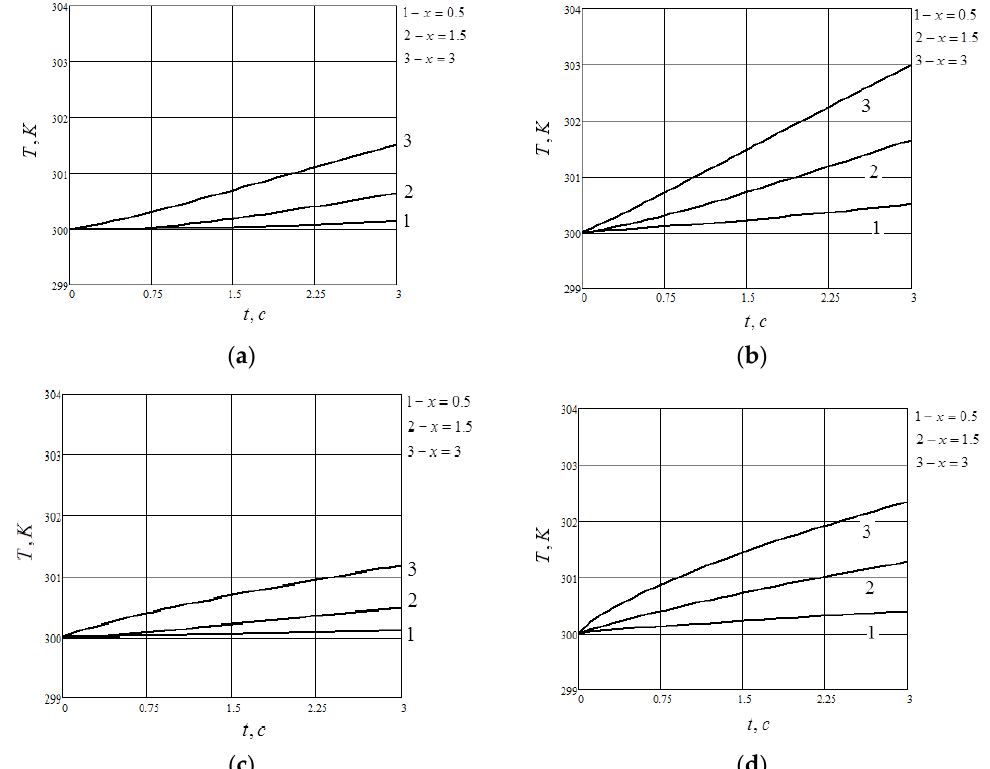
Figure 2. Temperature dependences on time in a semi-infinite body for: ( a ) α = 1, β = 2; ( b ) α = 1, β = 1.7; ( c ) α = 0.7, β = 2; ( d ) α = 0.7, β = 1.7. For all cases: q c = 1.8 W T 0 = 300